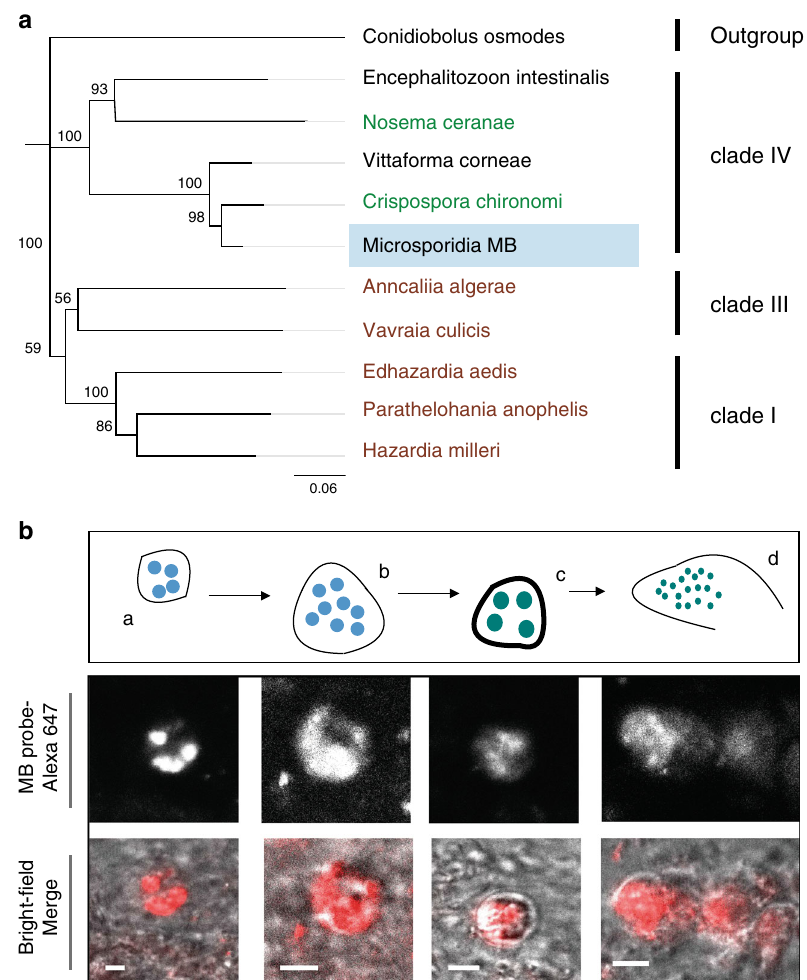
Fig. 1 A microsporidian associated with An. arabiensis populations in Kenya. a 18S rDNA-based phylogeny reveals that Microsporidia MB are in clade IV of the Microsporidia. Labeled in brown are the microsporidian species known from mosquitoes. In green are microsporidians associated with other insect groups. Microsporidia MB 18S rDNA gene sequence deposited in GenBank (accession number MT160806[https://www.ncbi.nlm.nih.gov/nuccore/ MT160806]) and in Source Data fi le. b Fluorescence in situ hybridization (FISH) staining of the diplokaryotic stages of Microsporidia MB merogony ( a, b ) and spore capsule formation ( c, d ) in An. arabiensis larval gut epithelial tissues. Red in the merge images is the MB probe-Alexa 647 FISH probe targeting Microsporidia MB . The scale bar is 1.5 μ m. Representative images as observed in four independent